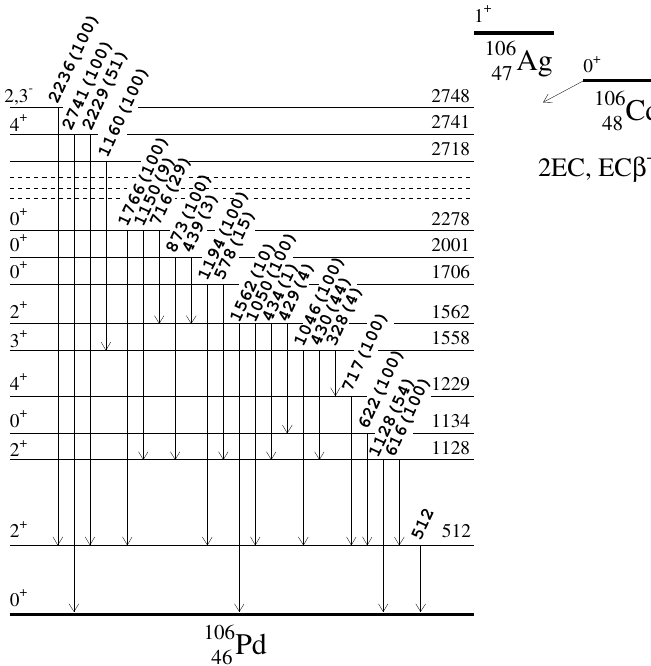
Figure 1. Simplified decay scheme of 106 Cd [36] (levels with energies in the energy interval (2283–2714) keV are omitted). The energies of the excited levels are in keV. Relative intensities of γ quanta are given in